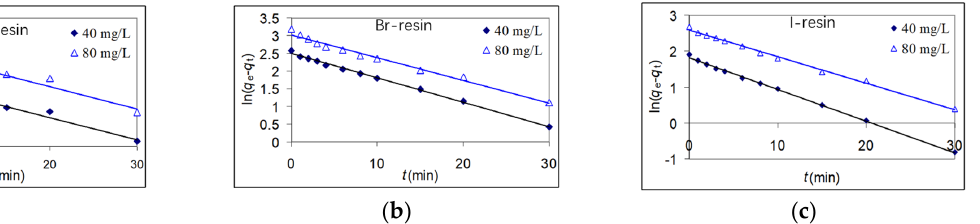
Figure 3. Pseudo  fi rst order plots of Cd 2+ adsorption on X   loaded resins. ( a ) Cl-resin, ( b ) Figure 3. Pseudo-first order plots of Cd 2+ adsorption on X − -loaded resins. ( a ) Cl-resin, ( b ) Br-resin, Br-resin, ( c ) I-resin. ( c ) I-resin. Table 2. Kinetic parameters with pseudo  fi rst order, pseudo  second order and intra  particle di ff u- Table 2. Kinetic parameters with pseudo-first order, pseudo-second order and intra-particle diffusion sion model analysis. model